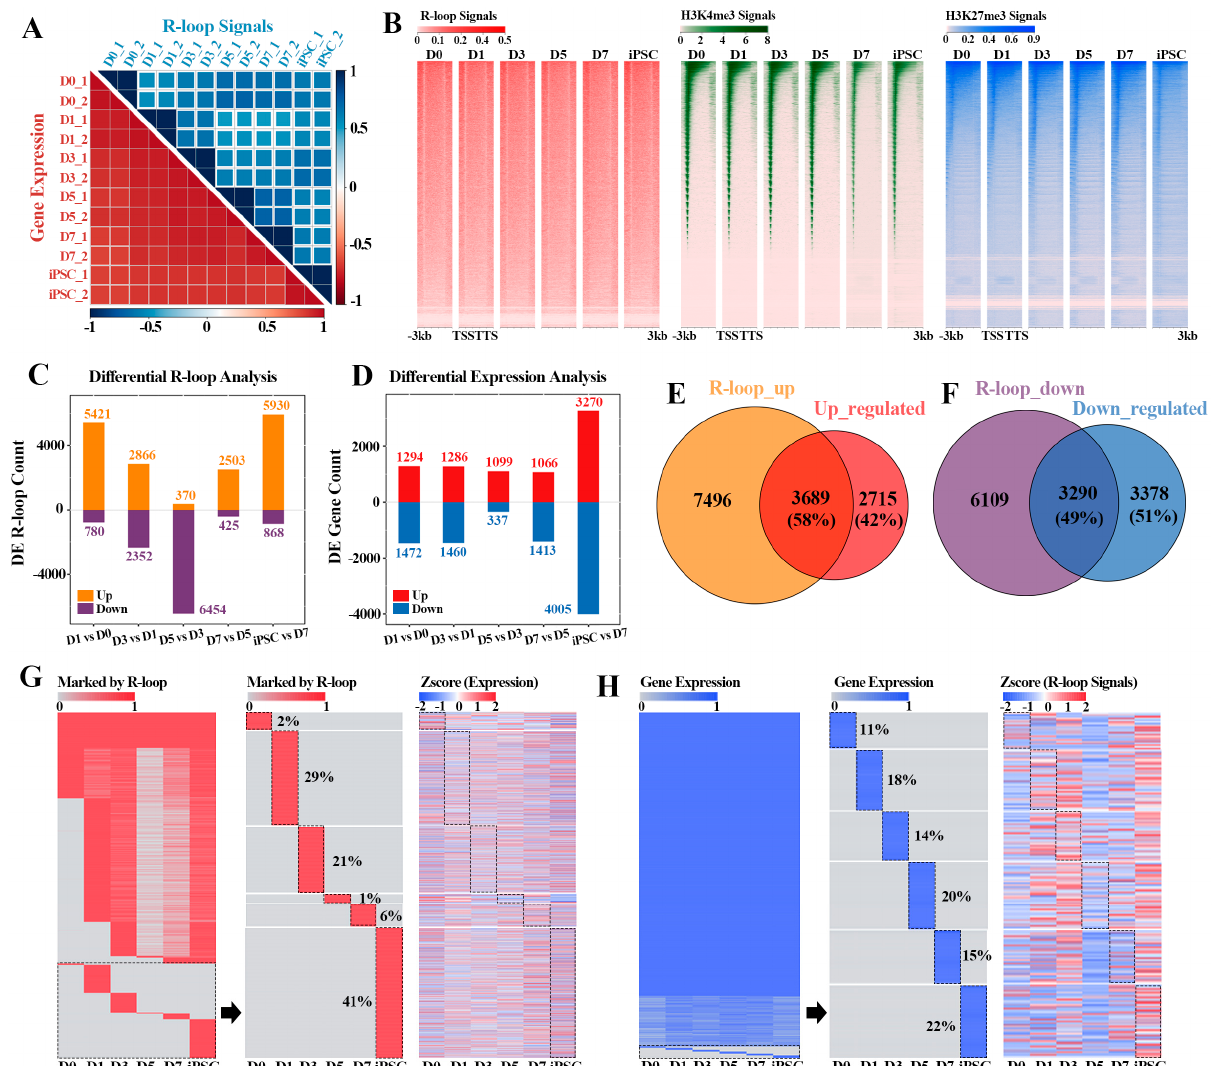
Figure 2. Reprogramming stage-specific R-loop modification and gene expression: ( A ) correlation heatmaps of different reprogramming stages according to R-loop signals (blue—top heatmap) and gene expression levels (red—bottom heatmap). Color scales represent Pearson correlation coeffi- cients (PCC) between different stages; ( B ) heatmaps displaying the signals of R-loop, H3K4me3 and H3K27me3 in flanking TSSs at different reprogramming stages. In each panel, each row represents a 3 kb region flanking TSS; ( C ) analysis of differential R-loop signals in adjacent stages of repro- gramming; ( D ) analysis of differential gene expression in adjacent stages of reprogramming; ( E ) Venn diagram revealing the overlap between genes with up-regulated R-loop signals (as shown in upper bar of ( C )) and up-regulated genes (as shown in upper bar of ( D )) between adjacent repro- gramming stages; ( F ) Venn diagram showing the overlap between genes with down-regulated R- loop signals (as shown in lower bar of ( C )) and down-regulated genes (as shown in lower bar of ( D )) between adjacent reprogramming stages; ( G ) heatmaps showing the genes marked by R-loop peaks (left) during reprogramming progress, part of genes marked by R-loop peaks with repro- gramming stage-specificity (middle) and the expression levels corresponding to these genes (right), respectively. Red—R-loop peaks; gray—no R-loop peaks; ( H ) heatmaps showing the dynamic ex- pression profiles (left) of genes during reprogramming progress, part of gene expression with re- programming stage-specificity (middle) and the R-loop signals corresponding to these genes (right), respectively. Blue—expression levels > 0; gray—no expression.